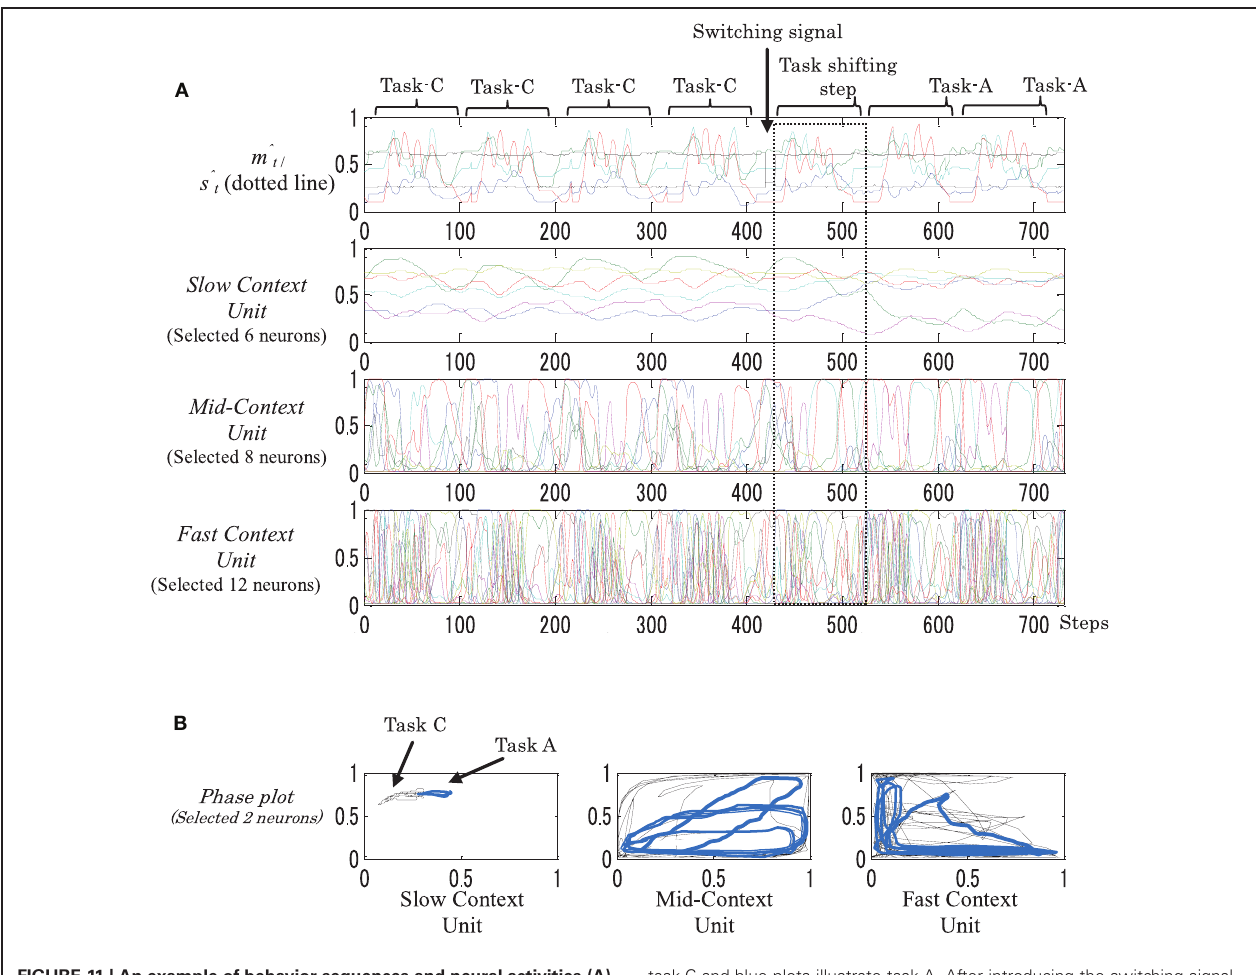
FIGURE 11 | An example of behavior sequences and neural activities (A), and phase plots (B) of a dynamic memory while performing task switching from task-C to task-A. In the phase plots: black plots illustrate